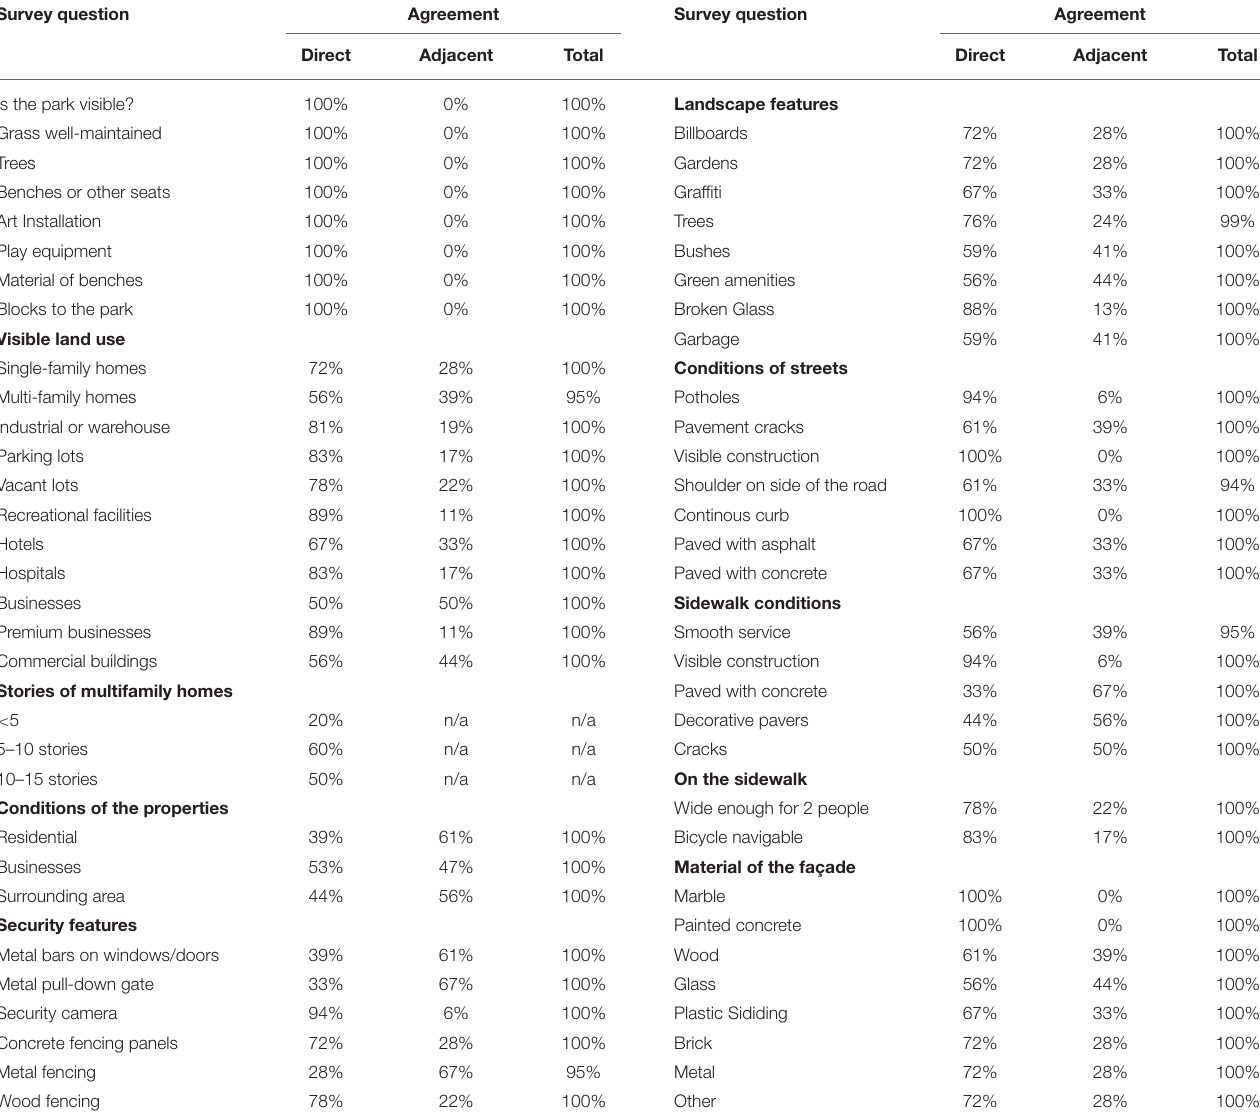
TABLE 3 | Agreement of survey responses between in situ and virtual field